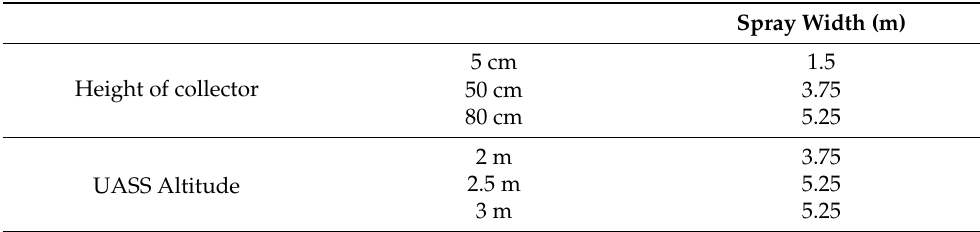
Table 2. Spray width of